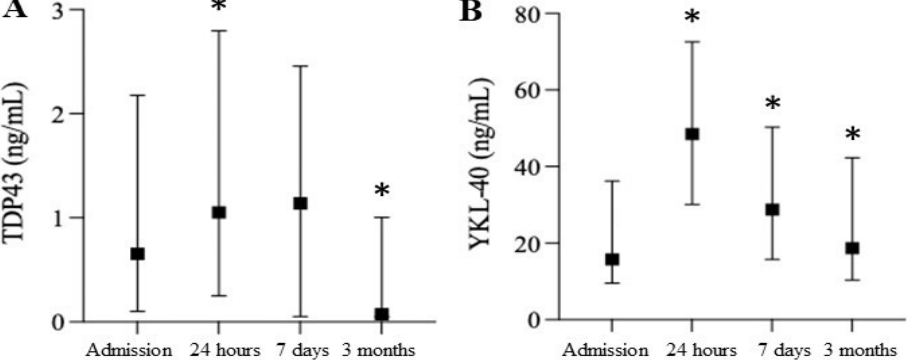
Figure 3. Time course of neuroinflammation markers after cardiac surgery. Levels of TDP43 ( A ) and YKL-40 ( B ) at baseline, 24 h, 7 days, and 3 months. * p < 0.05.